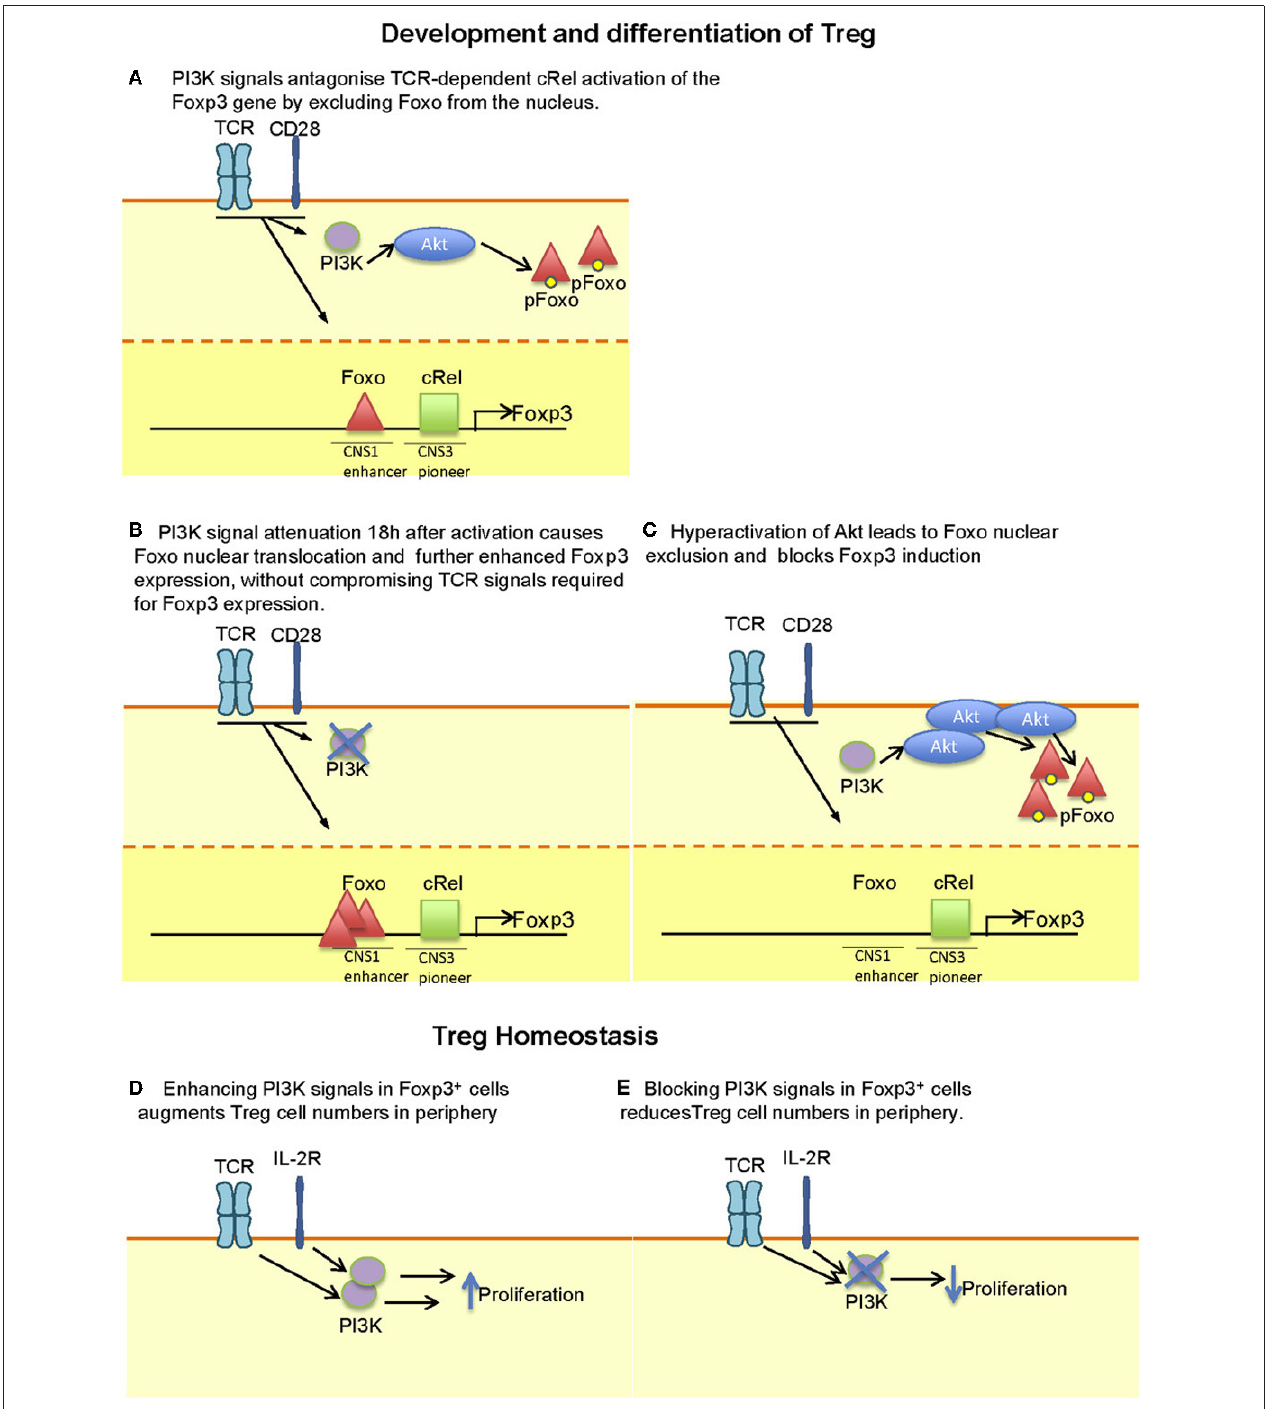
FIGURE 1 | Context-dependent effect of PI3K signaling on Treg development, differentiation and maintenance. (A) During thymic development, attenuation of PI3K signaling may be required to enhance the translocation of Foxo proteins to the nucleus where they enhance the expression of Foxp3. (B) The capacity of PI3K signaling to antagonize is illustrated during the in vitro differentiationof Foxp3 − CD4 T cells to Foxp3 + T cells where signal attenuation after 18h facilitates Foxo nuclear translocation. It is worth noting that earlier inhibition may interfere with TCR-dependent signals that favor Foxp3 expression. (C) Hyperactivation of